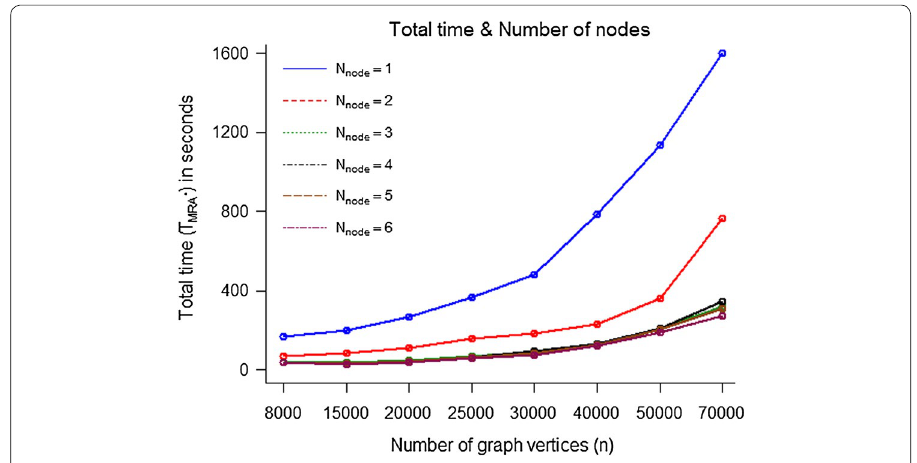
Fig. 12 Influence of number of nodes on the the computation